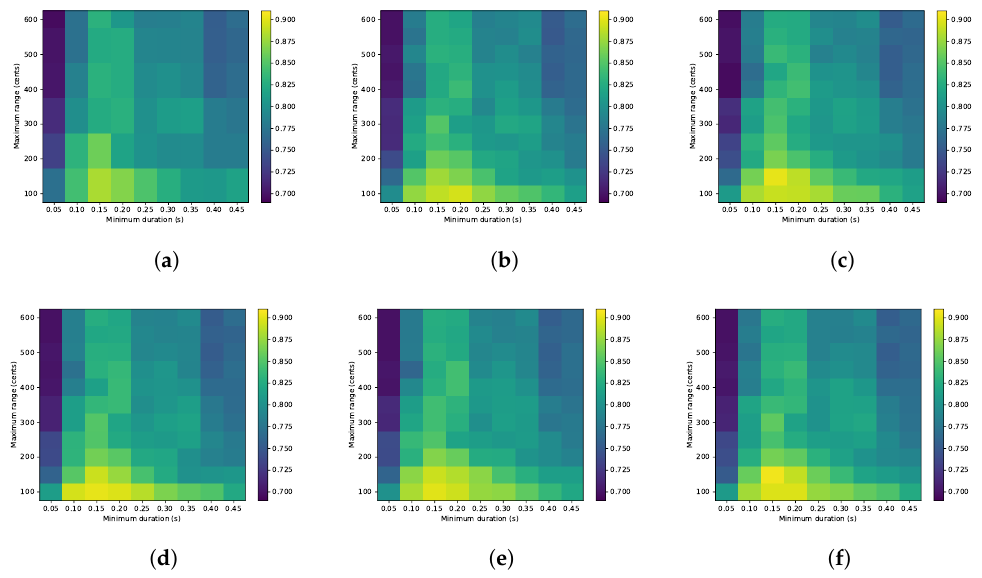
Figure 6. Speech/singing classification F-score for different number of steps per semitone. ( a ) one step per semitone; ( b ) two steps per semitone; ( c ) three steps per semitone; ( d ) four steps per semitone;